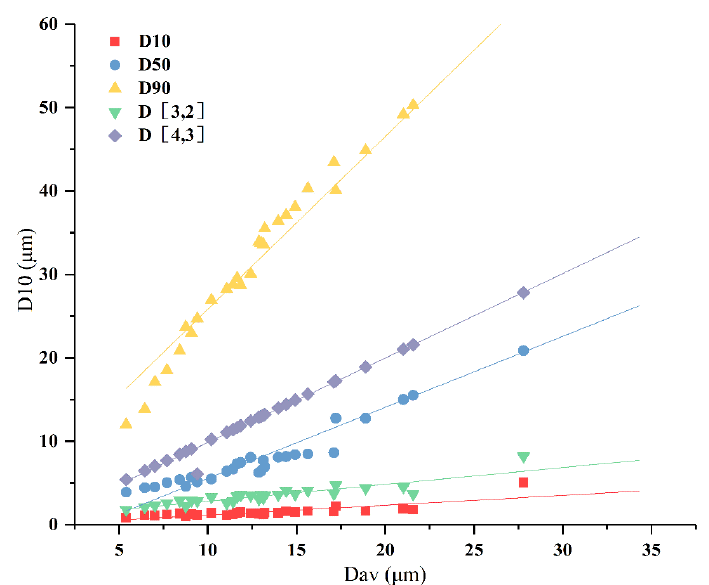
Figure 4. Scatterplot of characteristic parameters of particle size distribution; regional weathering crust samples.